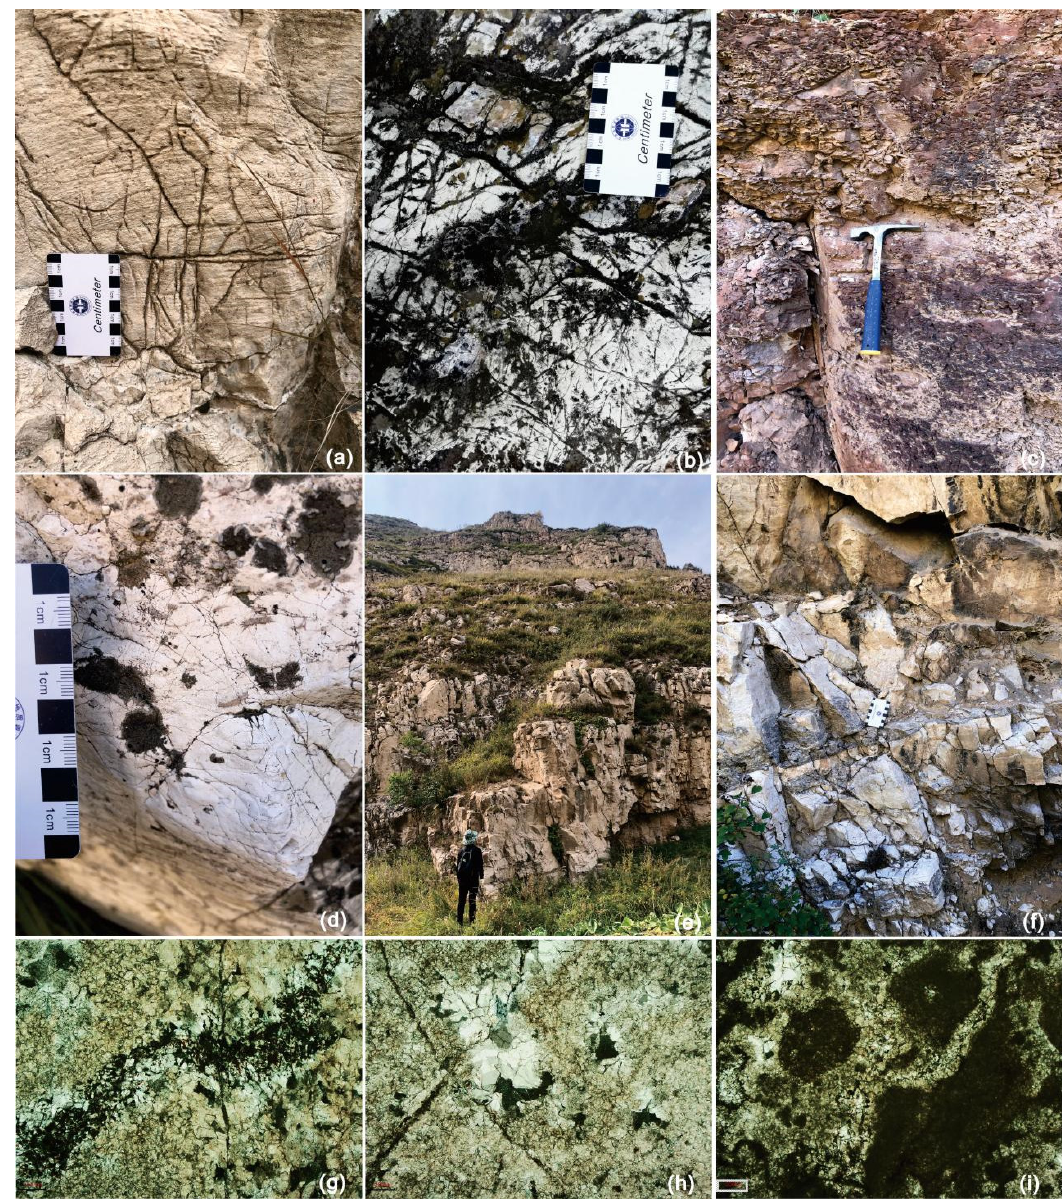
Figure 7. Rock characteristics of the Jixian System: ( a – f ) field outcrop, ( g – i ) microscopic thin section).